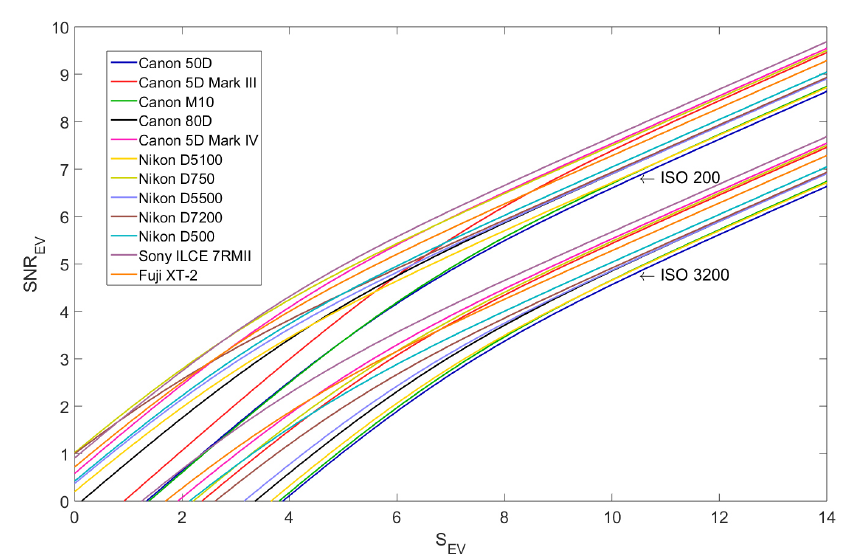
Figure 16. Photographic SNR curves for ISO 200 and